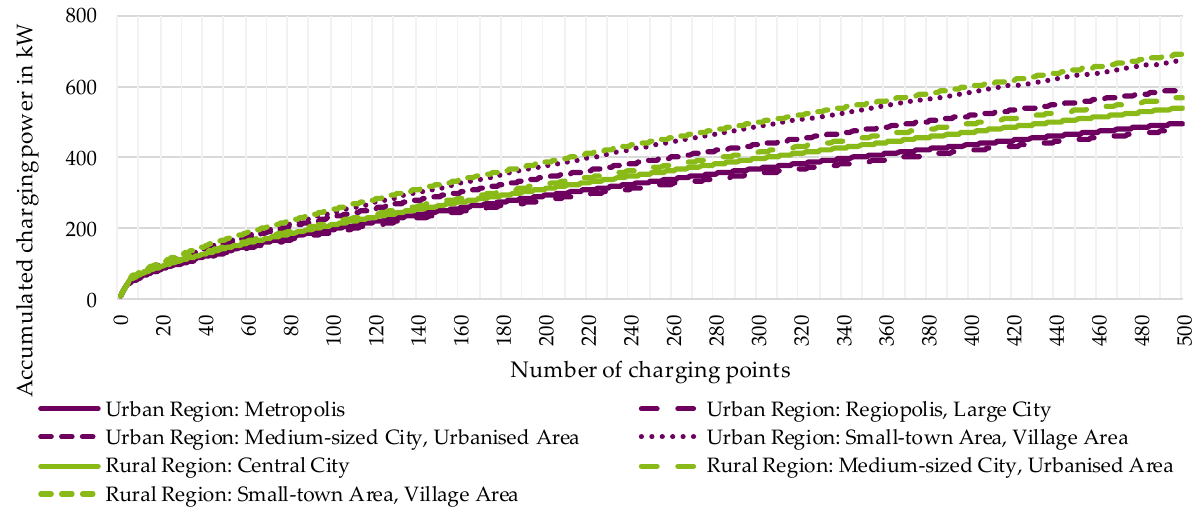
Figure A10. Accumulated charging power in kW for 22 kW charging points up to 500 charging points for seven area types.